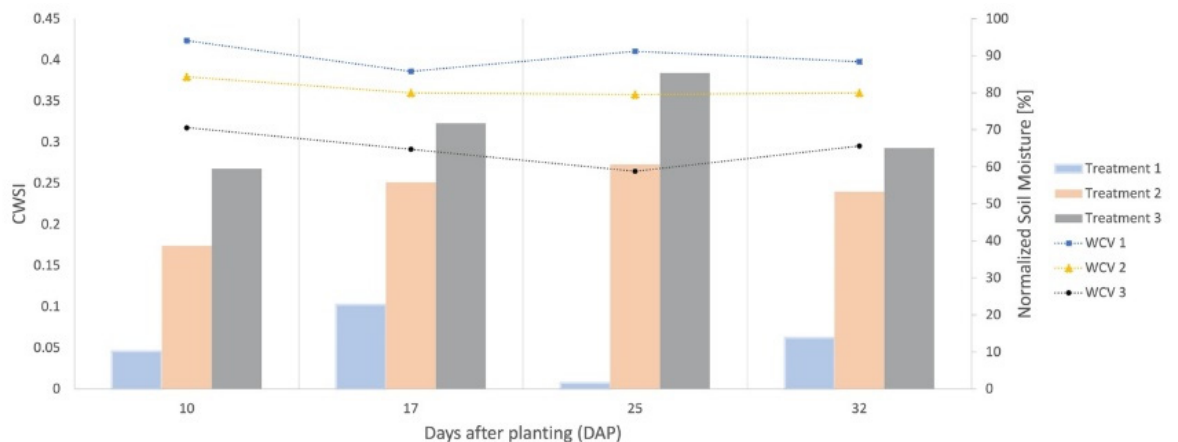
Figure 16. Levels of water stress throughout the entire arugula cycle. Soil moisture was normalized by the field capacity of each treatment, thus equaling the references used for measurement. CWSI (Crop Water Stress Index). Treatment 1 (T 1 = 85% FC (Field Capacity)); Treatment 2 (T 2 = 75% FC); Treatment 3 (T 3 = 55% FC). WVC 1 (Volumetric Water Content) for Treatment 1, WVC 2 (Volumetric Water Content) for Treatment 2, WVC 3 (Volumetric Water Content) for Treatment 3.